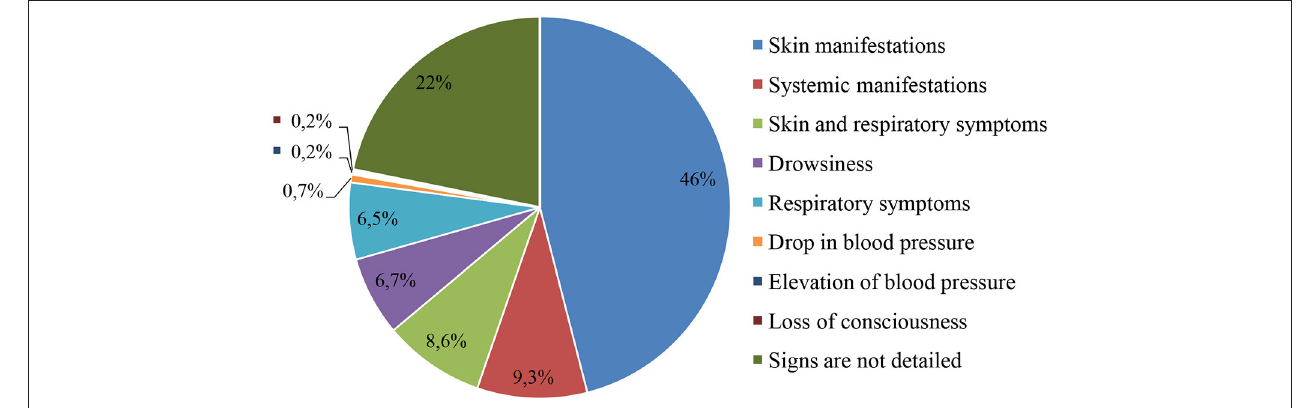
FIGURE 4 | Manifestations of adverse reactions to medications observed in young children.